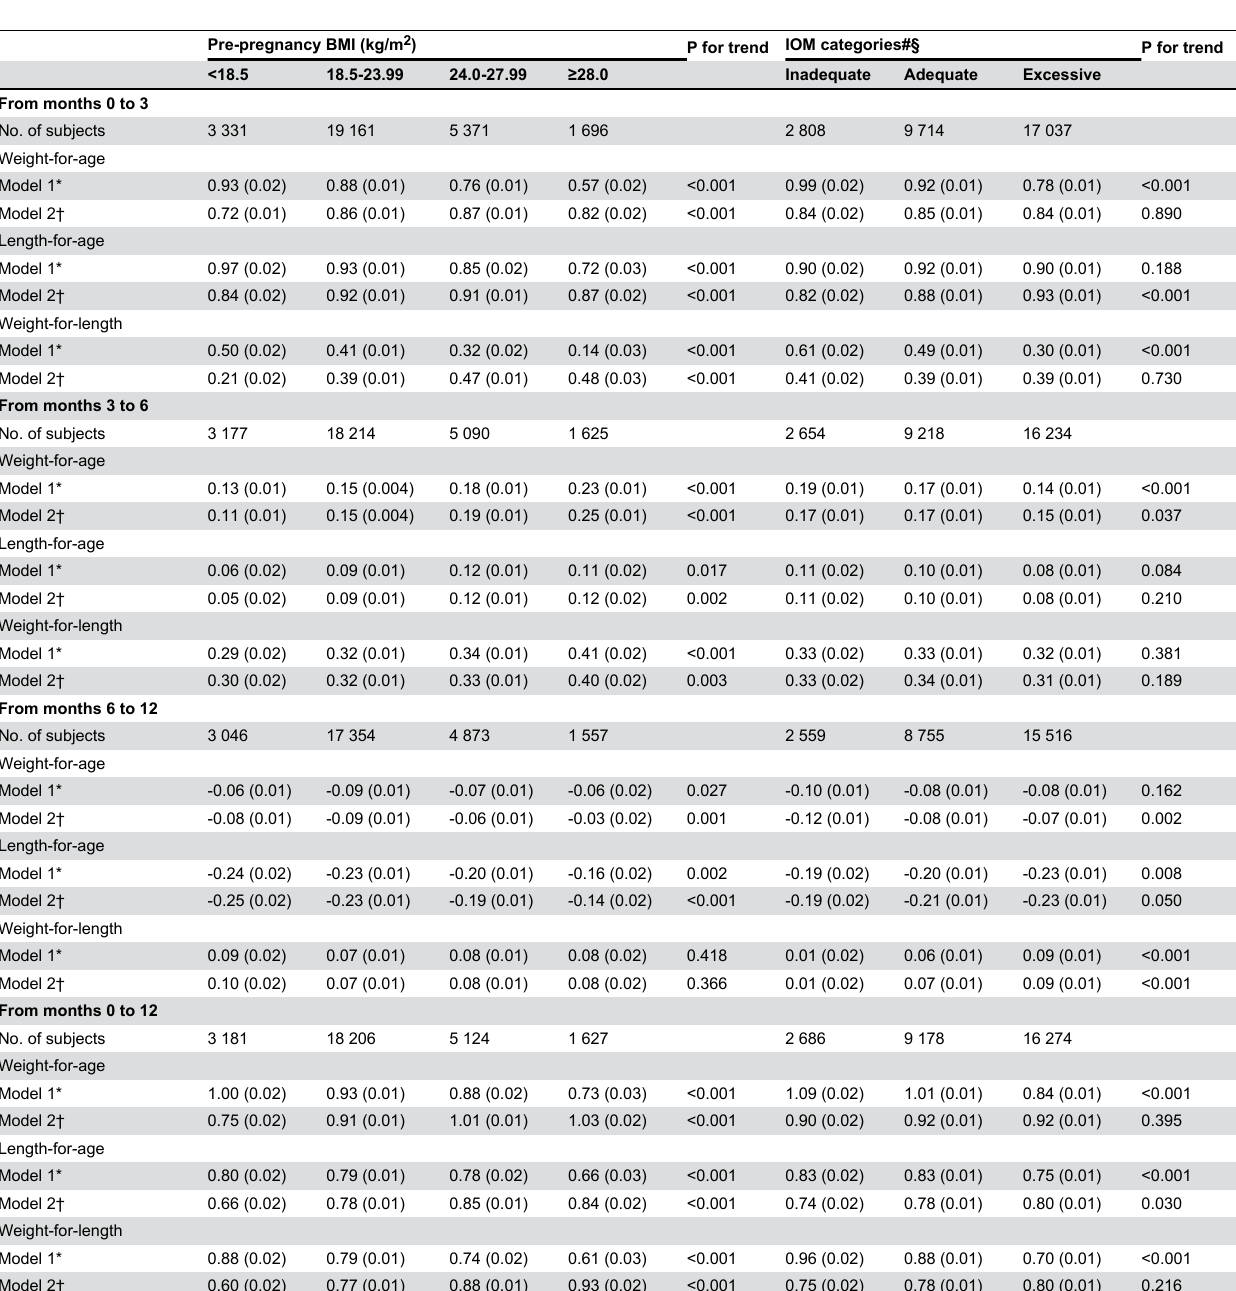
Table 3. Changes in Z scores for body weight, body length and weight for length from birth to months 3, 6, 9, and 12 according to pre-pregnancy BMI and gestational weight gain